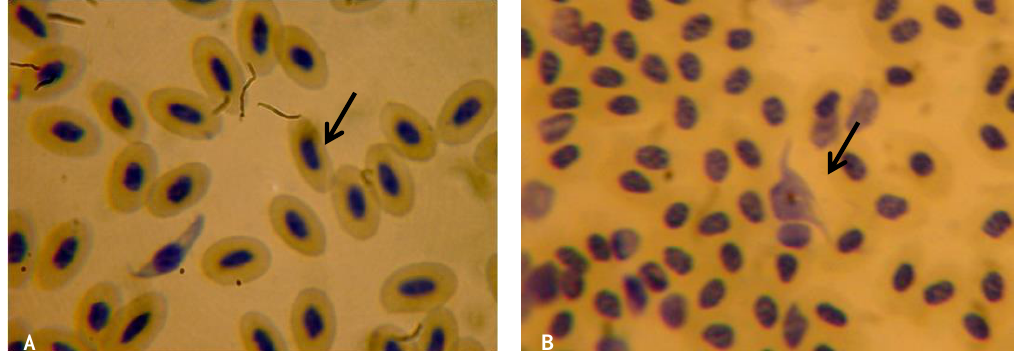
Figure 3; A and B: Chickens blood smears showing Leucocytozoon spp.